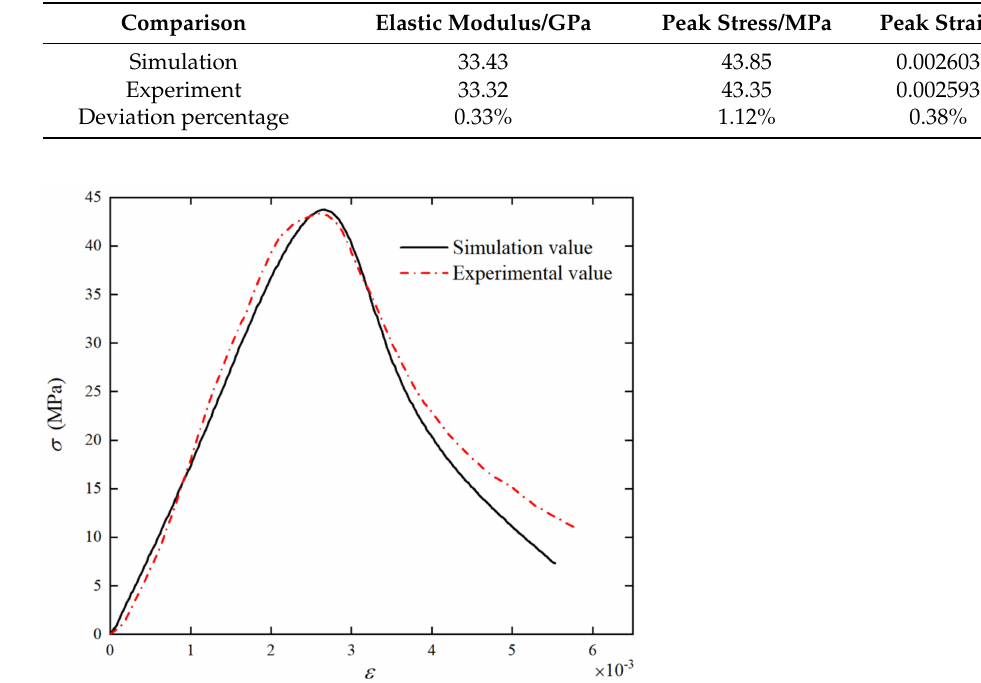
Figure 9. Comparison of the stress–strain curves of the C40 concrete indoor test and numerical